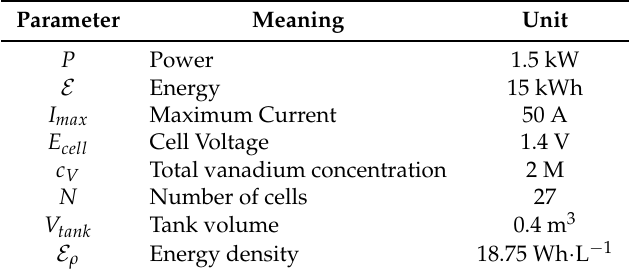
Table 4. Battery sizing